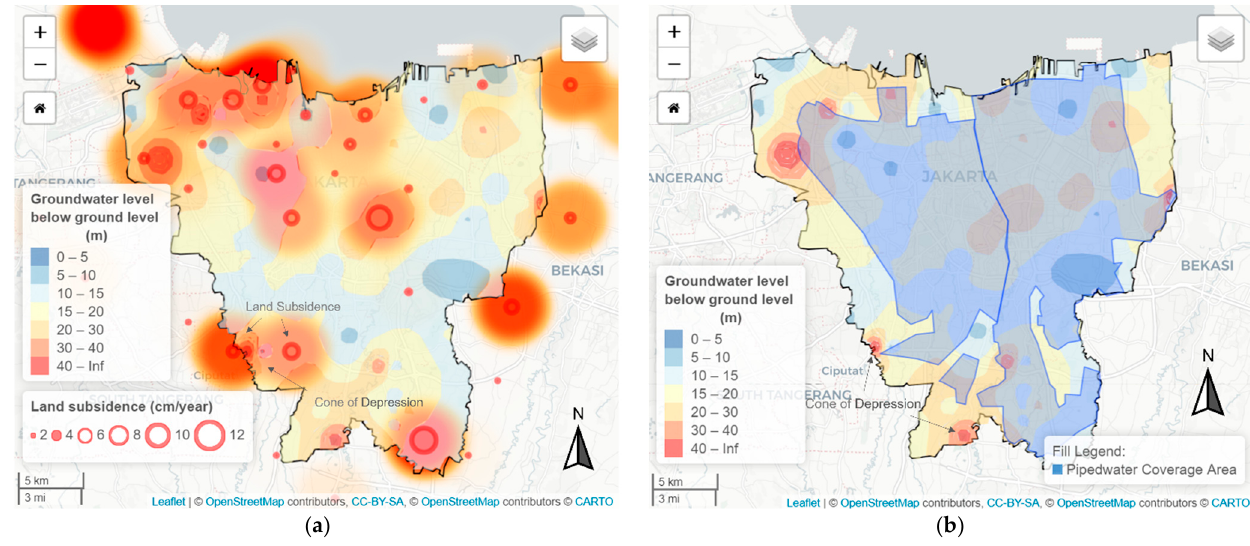
Figure 3. ( a ) Groundwater level below ground level and land subsidence rates and ( b ) groundwater level below ground level and piped water service area. Note: the areas indicated by the light blue color are the service areas of piped water.